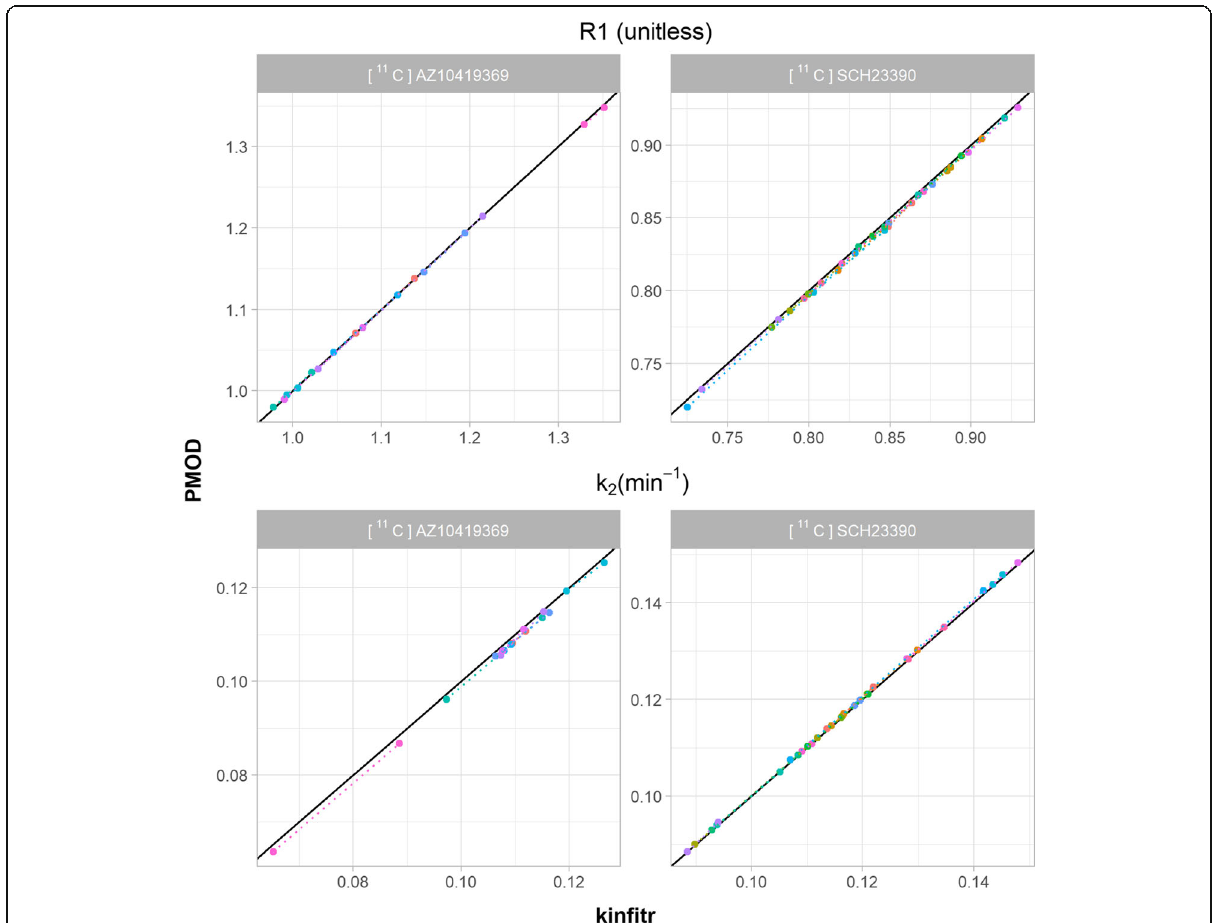
Fig. 3 Microparameter comparison for the simplified reference tissue model (SRTM). The relationship between the values of individual rate constants calculated by either kinfitr or PMOD. The results for the radioligand [ 11 C]AZ10419369 are derived from the occipital cortex ROI, whereas the results for [ 11 C]SCH23390 correspond to the striatum. The diagonal line represents the line of identity. Each colour corresponds to a different subject, and the dotted lines connect both measurements from the same